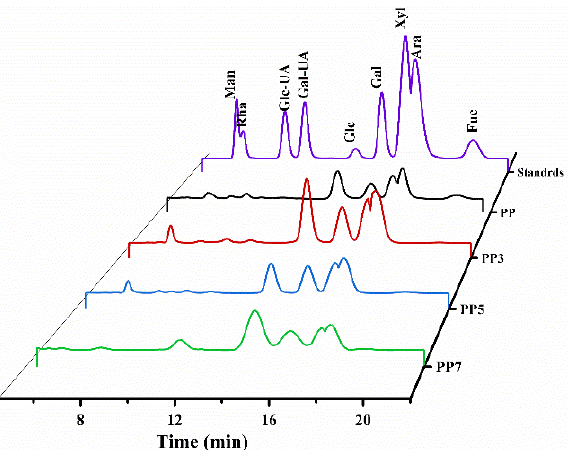
Figure 3. High-performance liquid chromatogram profiles of compositional monosaccharides of PP, PP3, PP5, and PP7.